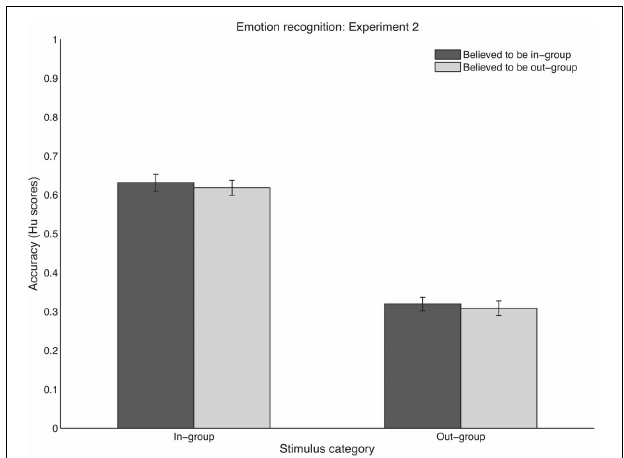
FIGURE 3 | Recognition performance in Experiment 2 using (raw) Hu scores, for in-group stimuli (left cluster) and out-group stimuli (right cluster). Sounds were believed to be in-group (dark bars) or out-group (light bars). Scores range between zero (no accurate responses) and one (perfect performance). Error bars denote one standard error of the